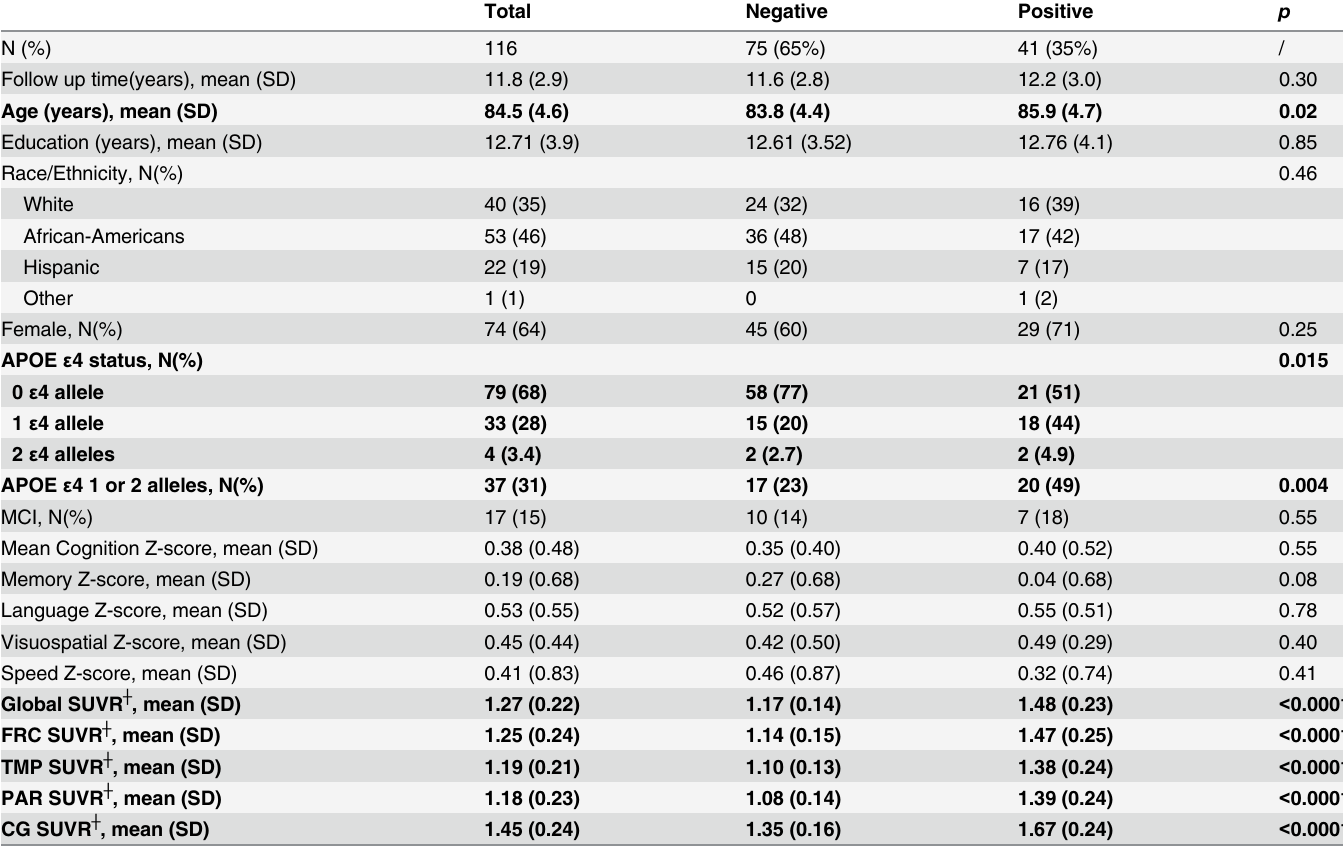
Table 1. Characteristics of study participants according to negative or positive visual reading of brain A β